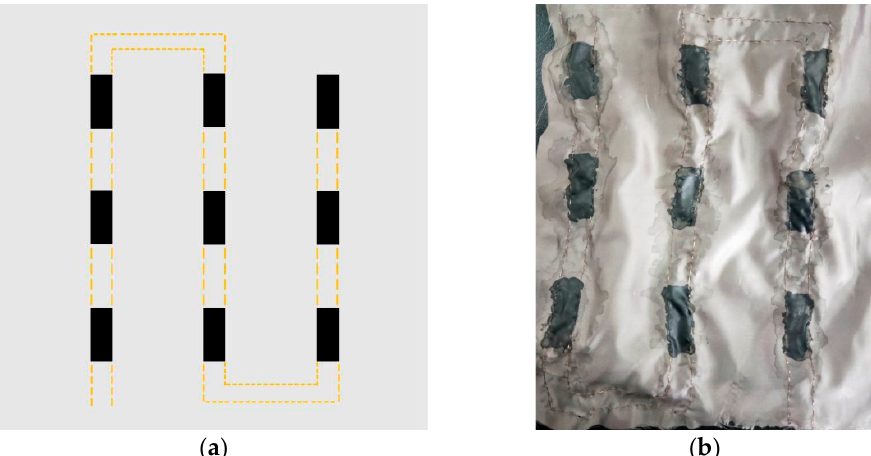
Figure 1. System concept with 9 pieces of SWCNTs connected via conductive threads ( a ) design image, ( b ) sample image.